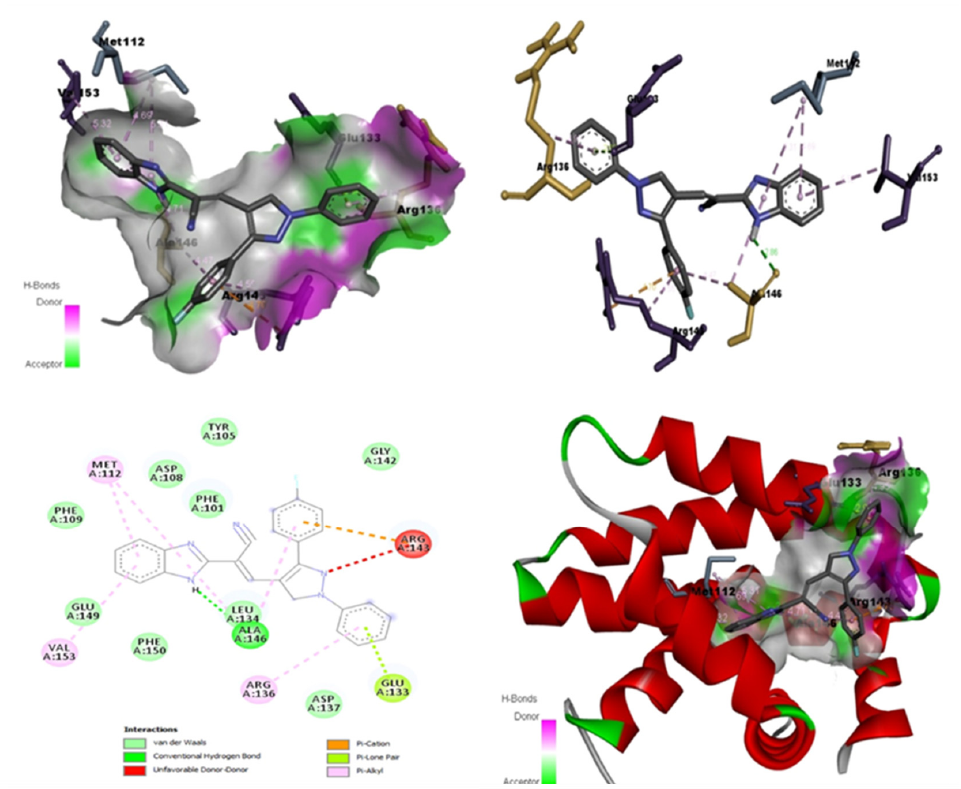
Figure 14. The 2D and 3D interactions of BCL-2 with compound 6h . phenyl)-1H benzo[d] imidazol-1-yl)propan-2-one was used to prepare a series of 6-ben-